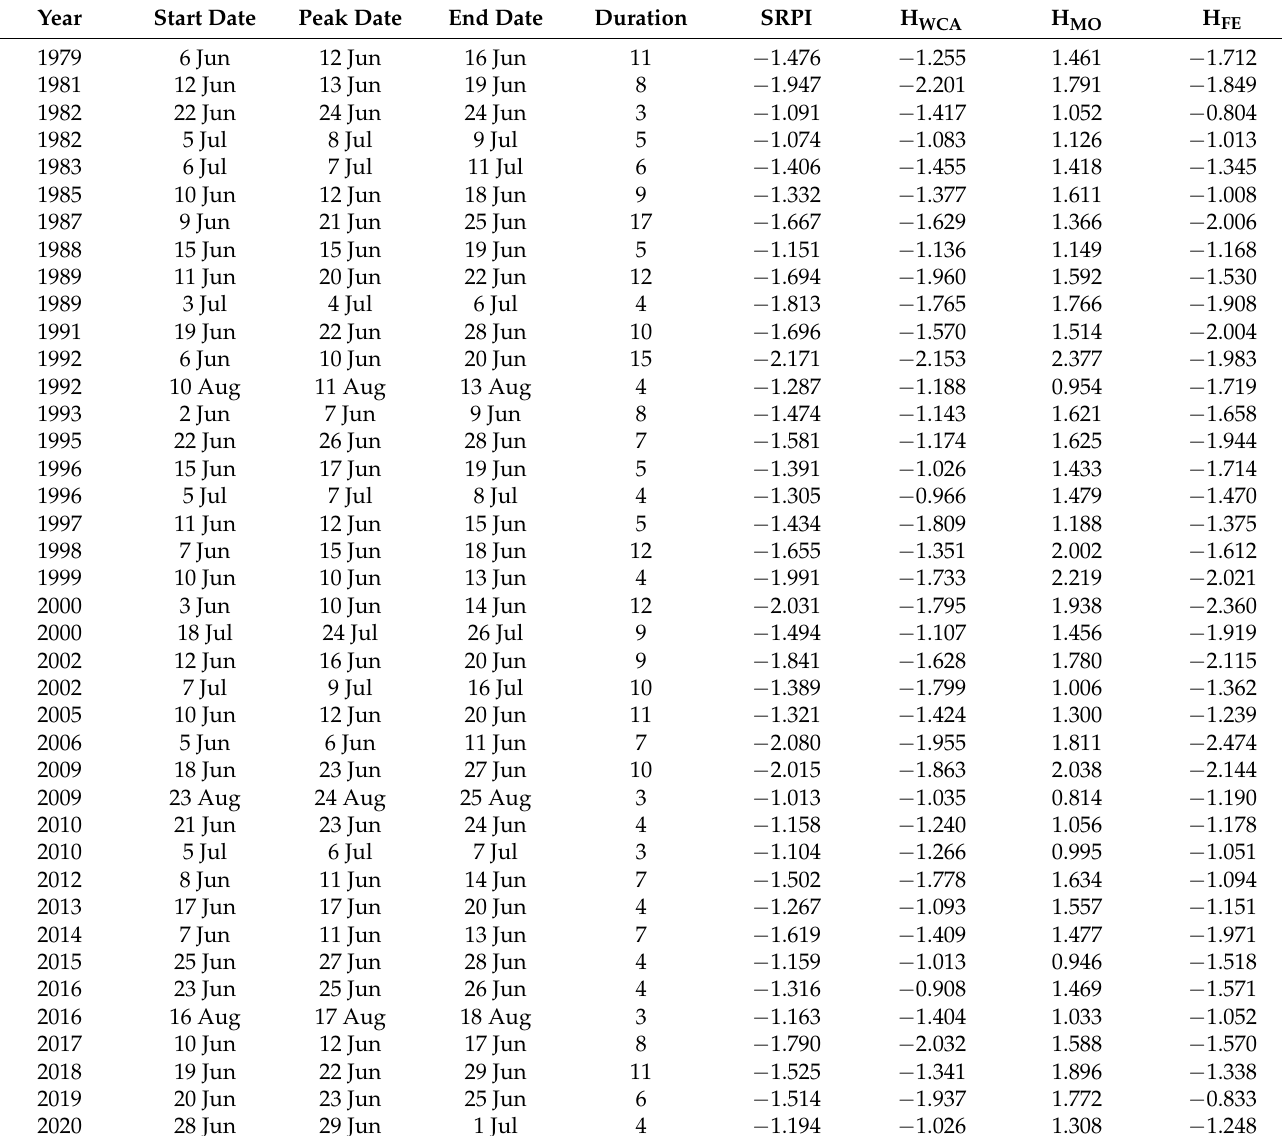
Table 2. The year, start date, peak date, end date, duration (unit: day), average SRPI, and H WCA , H MO , H FE of the 40 SRP −